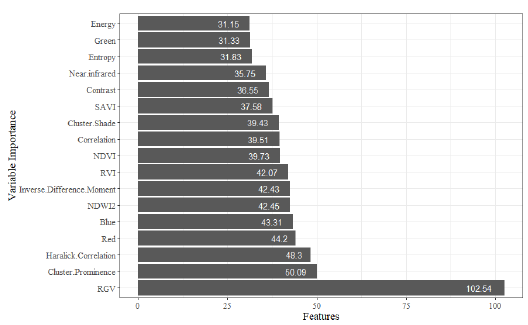
Figure 3. Features selected for classification, ranked by